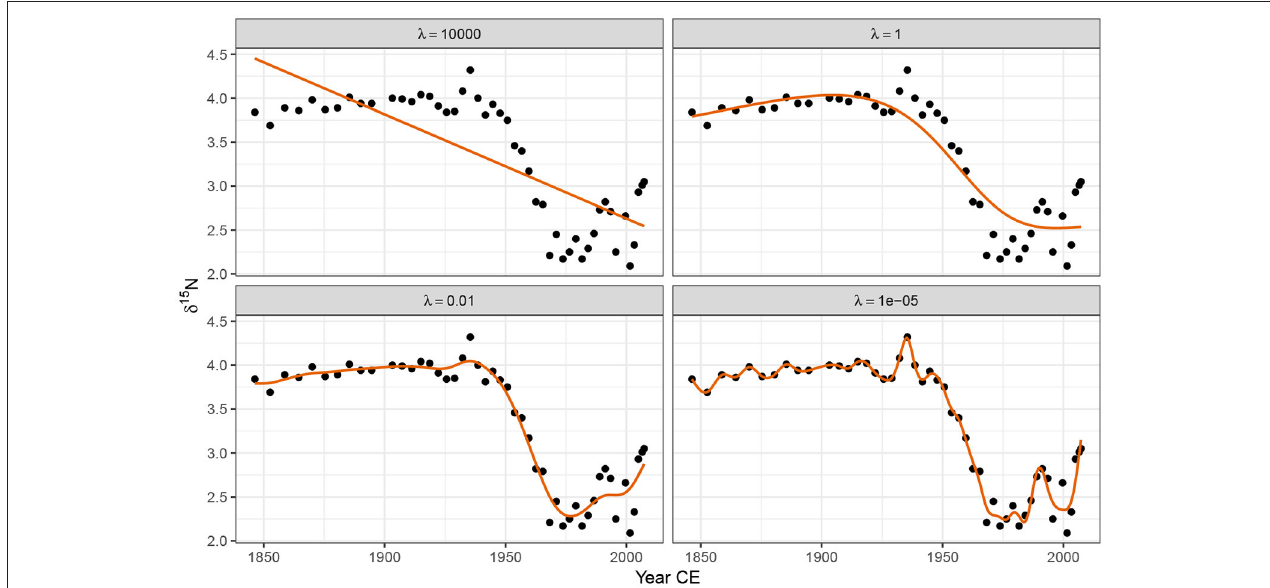
FIGURE 5 | The effect of the smoothness parameter λ on the resulting wiggliness of the estimated spline. Large values of λ penalise wiggliness strongly, resulting in smooth trends (upper row), while smaller values allow increasingly wiggly trends. The aim of automatic smoothness selection is to find an optimal value of λ that balances the fit of the model with model complexity to avoid